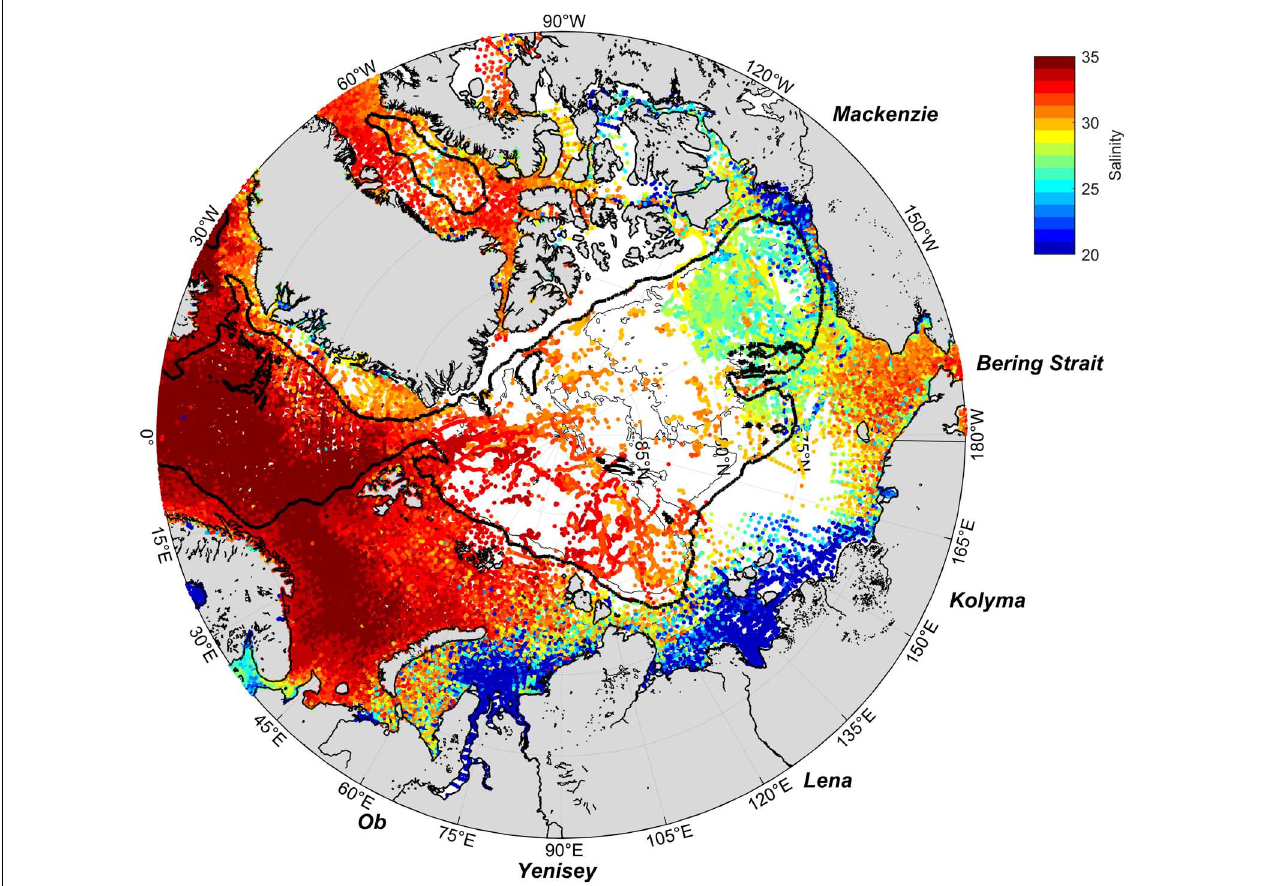
FIGURE 1 | Sea surface salinity from the World Ocean Database. Note that the color scale limits minimum salinities to